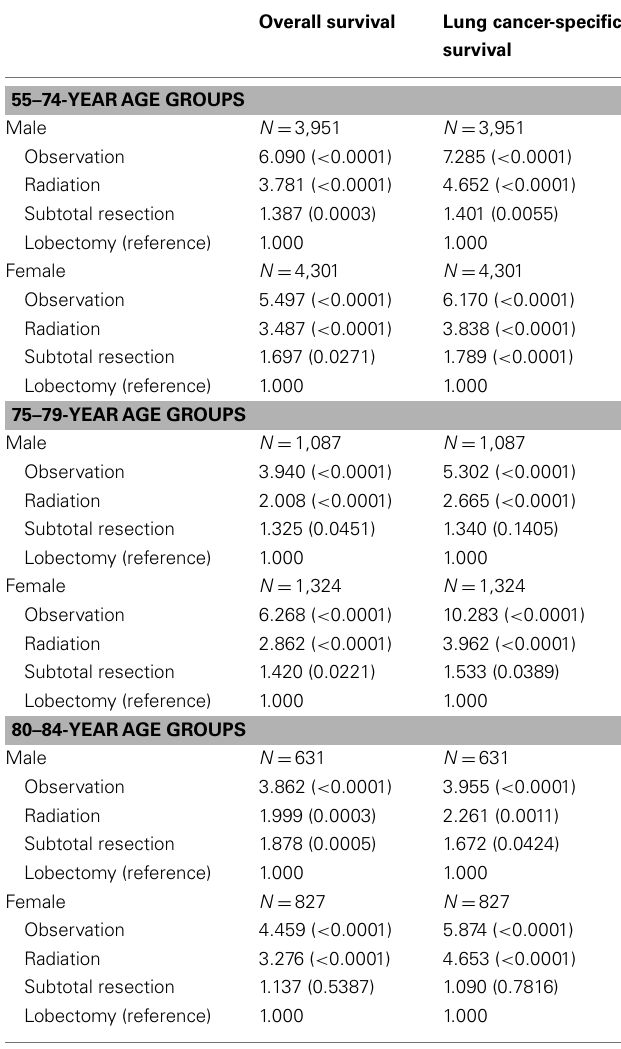
Table 3 |Adjusted hazards ratios for survival among the elderly age group: comparison between treatments